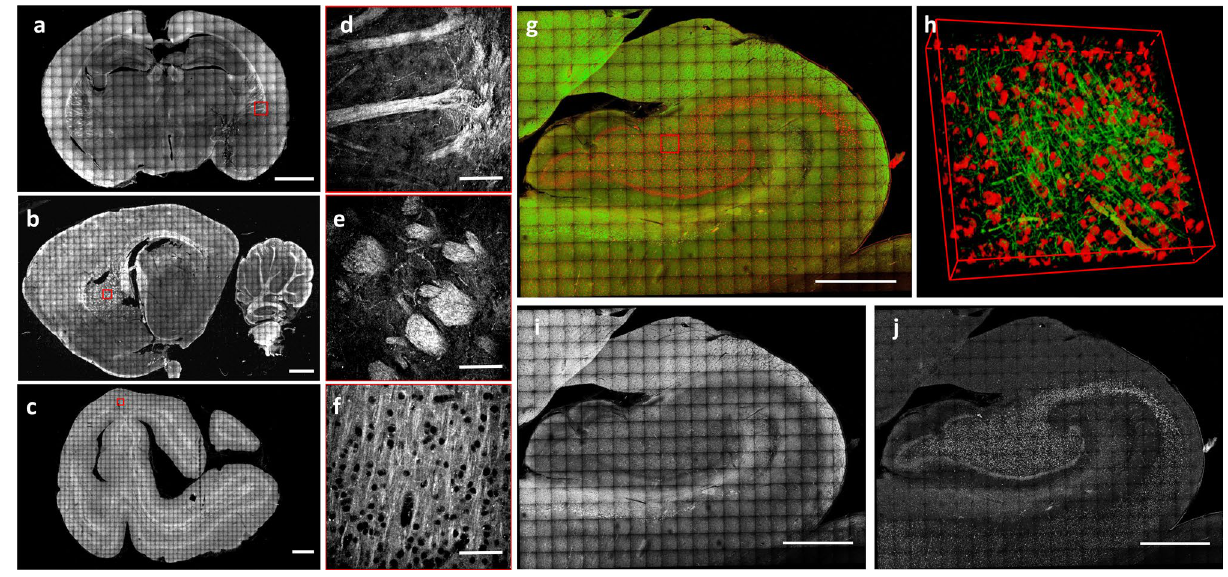
Figure 3. High-resolution reconstruction. ( a – c ) Maximum intensity projection (MIP) of the reconstruction of 60-µm-thick brain sections treated with MAGIC: mouse ( a ), rat ( b ), and vervet monkey ( c ), respectively. Scale bar = 1 mm. ( d – f ) Magnified inset corresponding respectively to the red boxes in a , b , c . Scale bar = 50 μm. ( g ) MIP of the mesoscale reconstruction of a human hippocampus 60-µm-thick coronal section. Scale bar = 1 mm. ( h ) 3D rendering (450 × 450 × 60 µm 3 ) of the stack indicated by the red box in g. ( i ) Green channel showing the myelinated fibers enhanced by MAGIC. ( j ) The red channel of the MIP in g showing the autofluorescence of the cell bodies produced by lipofuscin pigments. Images and the 3D rendering were prepared using Fiji (www. fiji. sc/ Fiji) 20